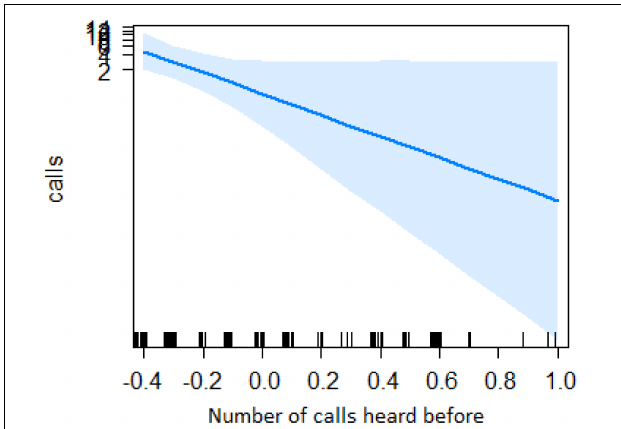
FIGURE 4 | Effect of the number of calls heard before on the number of calls when finding the snake ( Y -axis in log scale). X-axis data has been transformed so it could be better visualized.